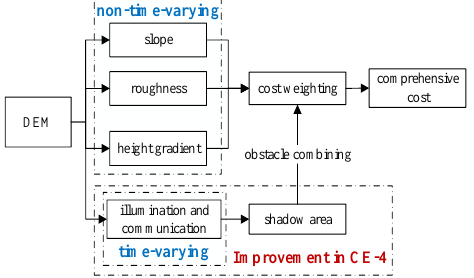
Figure 5. Flowchart of environment modeling for CE-4 path planning